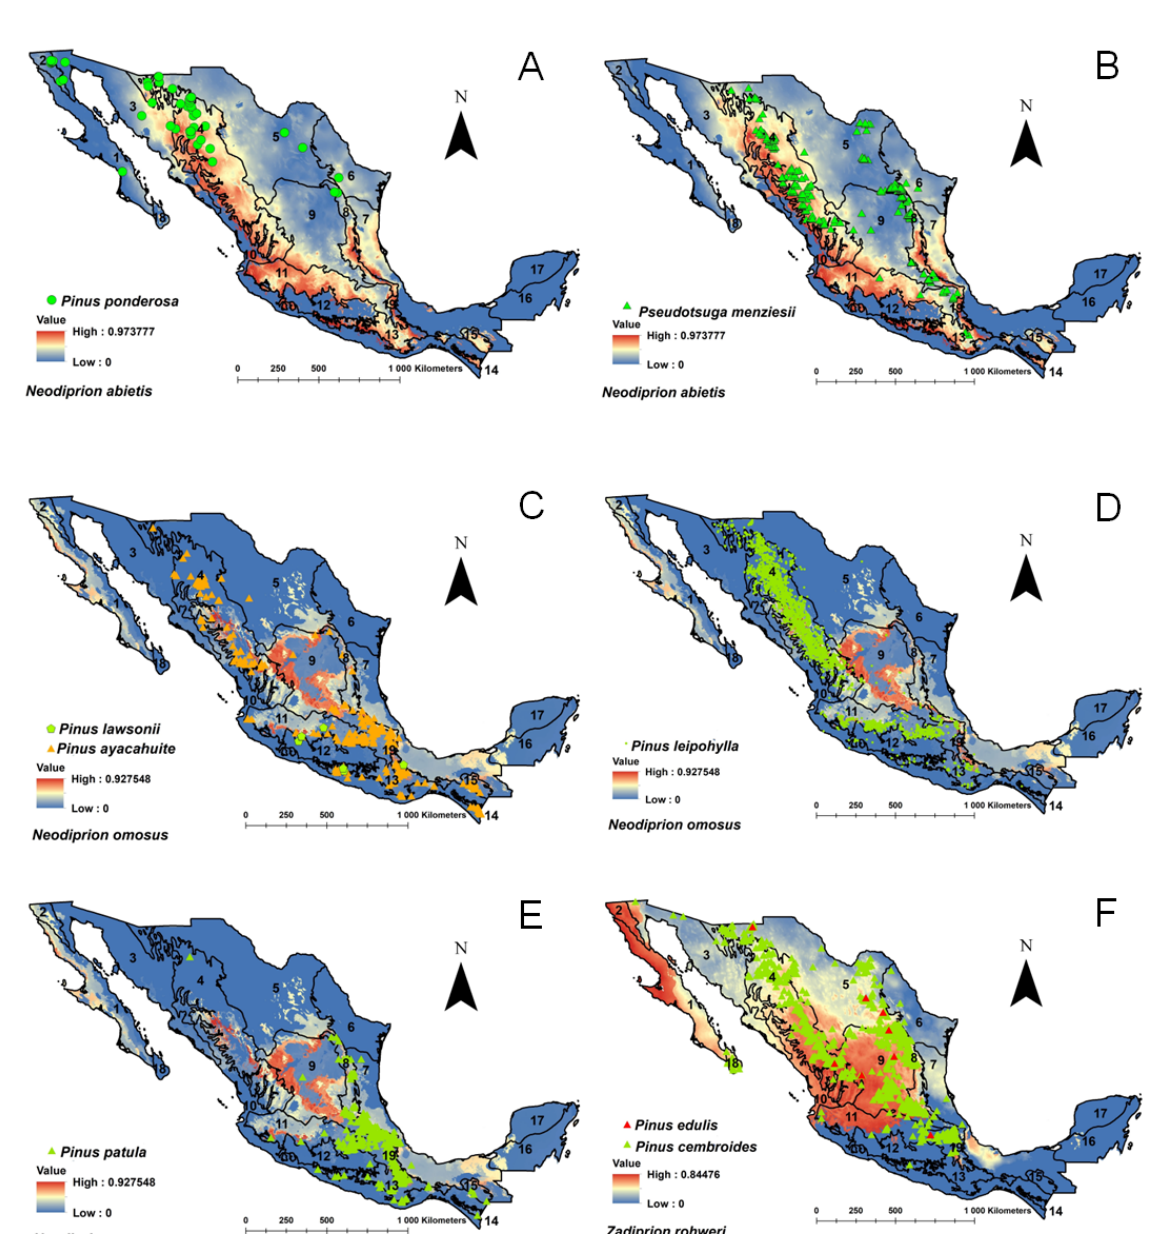
Figure 2. Distribution of hosts in Mexico for three species of sawflies (Hymenoptera: Diprionidae), projected according to the Mexican biogeographic provinces [53] and its ecological niche model. ( A , B ) Neodriprion abietis , ( C – E ) N. omosus , and ( F ) Zadiprion rohweri . For biogeographic provinces’ names, check Figure 1.